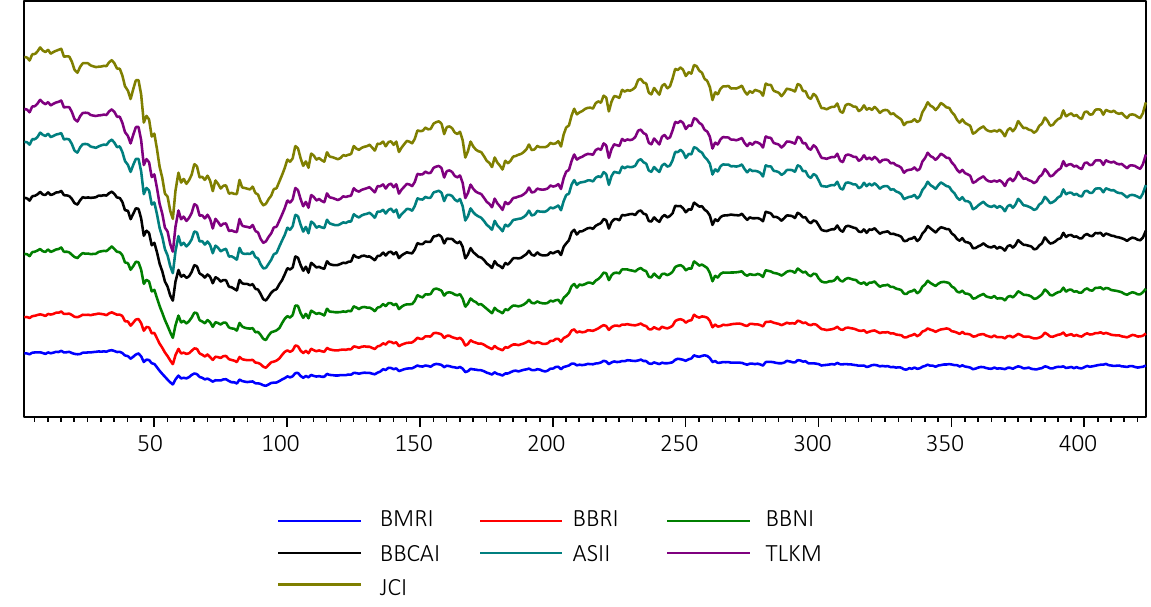
Figure 2. Top 6 capitalizations of the Indonesian stock